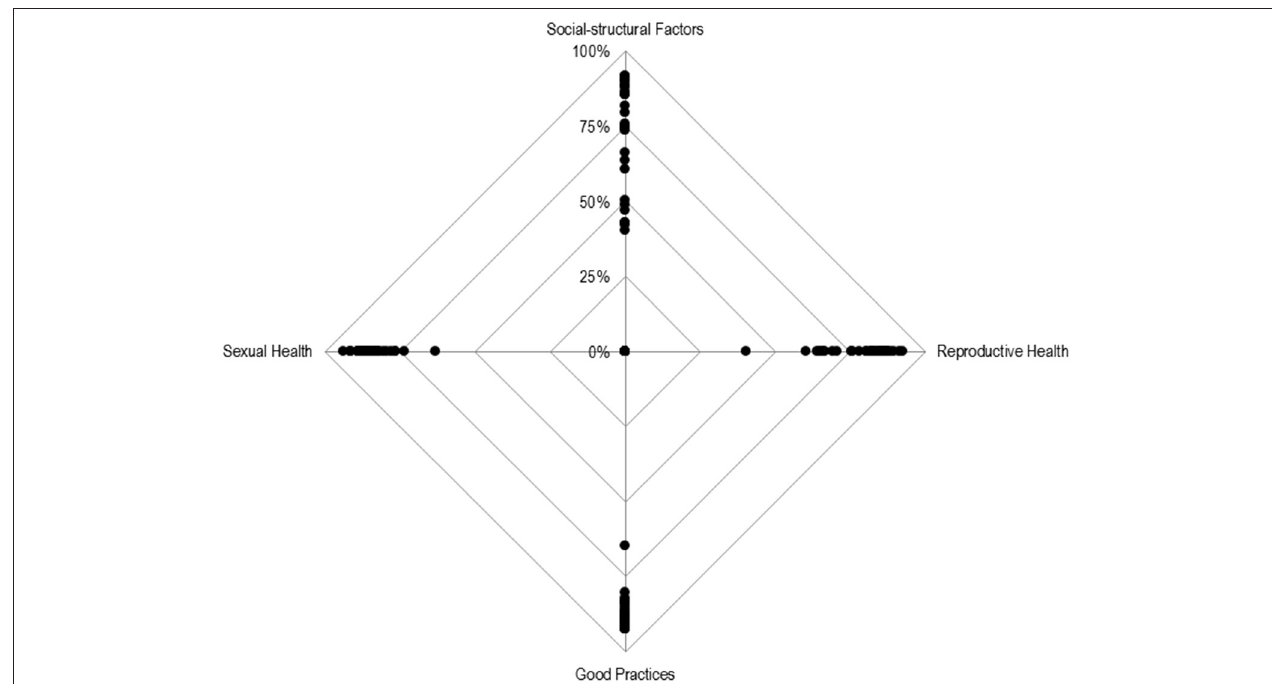
FIGURE 5 | Radar chart for the percentage of responses strongly agree + agree per dimension. Each point represents the percentage of agreement response (“I agree” and “I strongly agree”) for each item, per dimension.